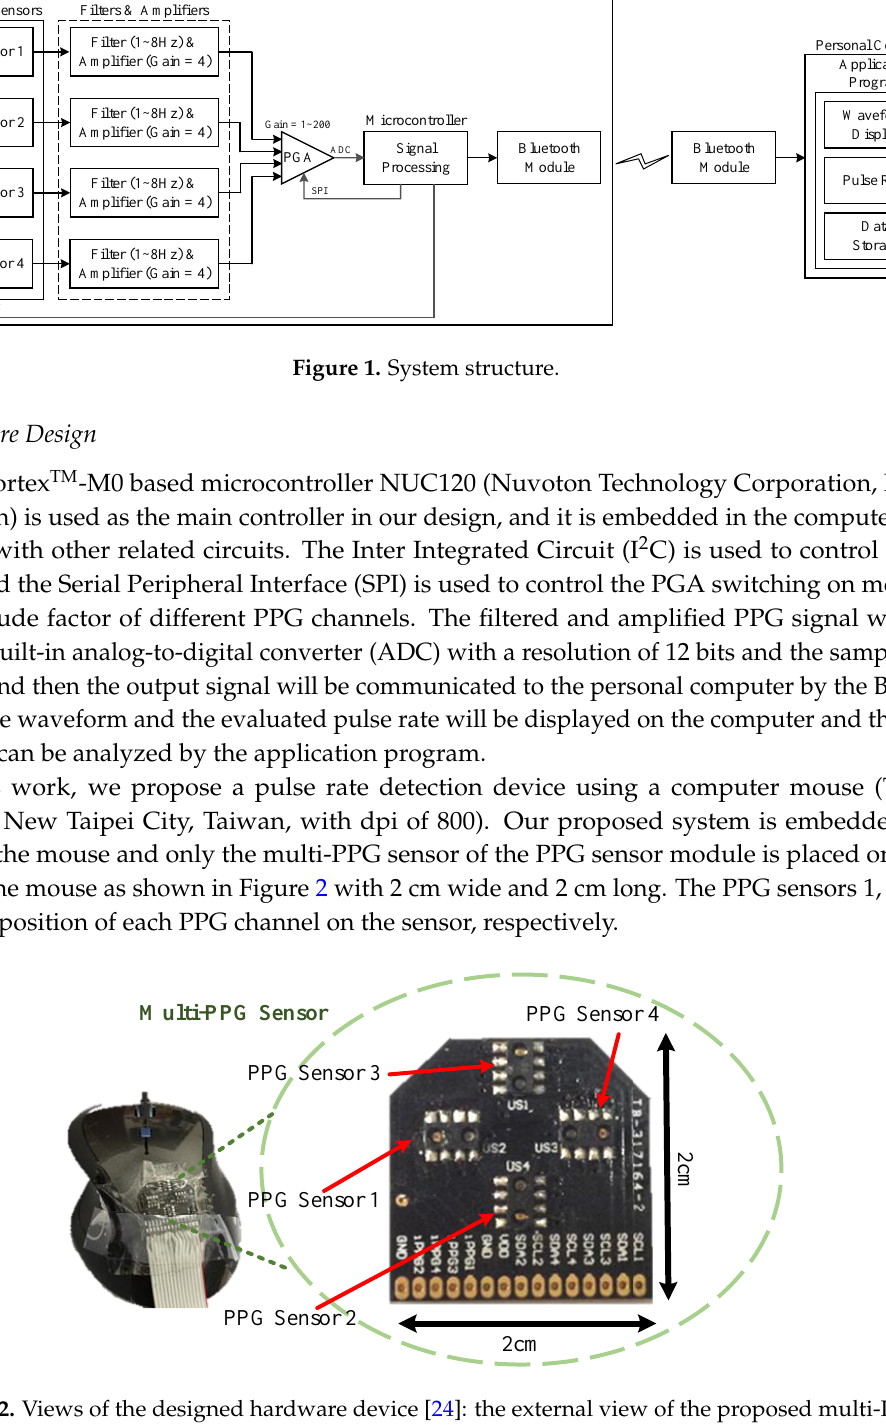
Figure 2. Views of the designed hardware device [24]: the external view of the proposed multi-PPG sensor with four channels placing on the top of the